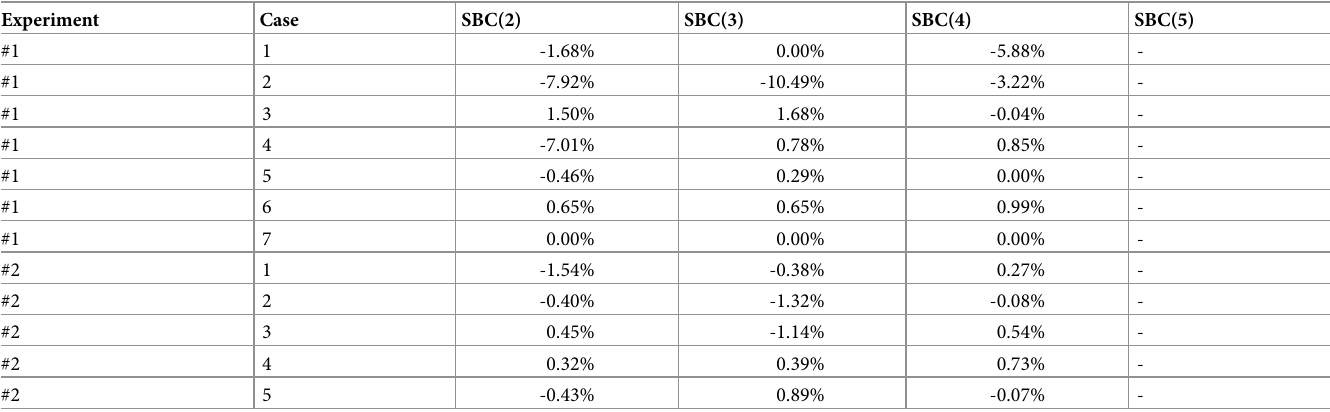
Table 5. The impact on revenue of changing number of buckets.